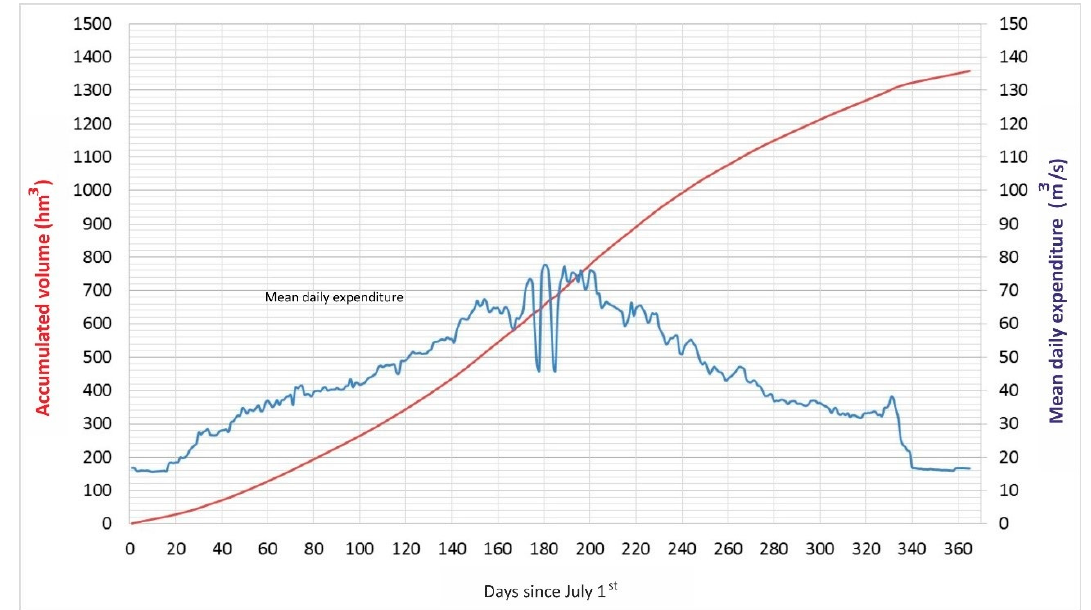
Figure 4. Mean daily water use curve and accumulated volume at Potrerillos Dam. (average values for 1 July 2006 to 30 June 2015).